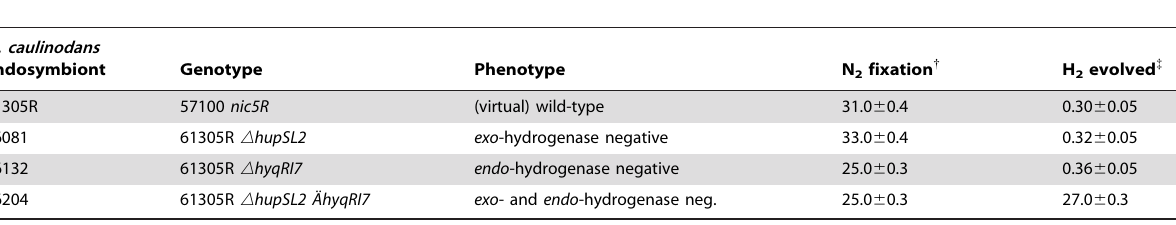
Table 1. N 2 fixation and H 2 recycling in S. rostrata–A. caulinodans stem